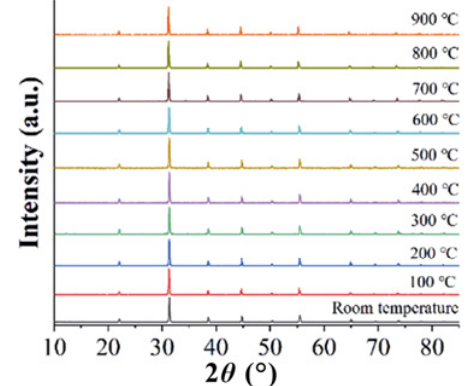
Fig. 4 High-temperature XRD patterns for BCF measured at different